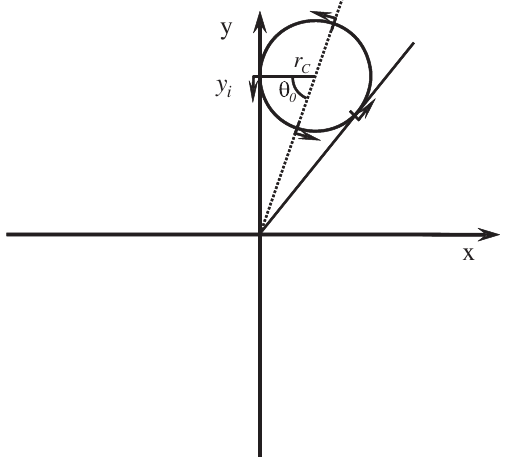
FIG. 20. Schematic of the transverse particle motion in a solenoid field after excitation by a radial kick towards the origin. The initial particle coordinates are y i , x i ¼ 0 , and r C denotes the cyclotron radius. The initial focusing kick is transferred into a pure angular motion with respect to the coordinate center at an ¼ arctan 4 cB 0 angle θ 0 ¼ arctan y i and at θ 0 þ π , while it leads to r C E sin ϕ a pure radial motion at an angle 2 θ 0 . rf forces act only in the radial direction; a compensation is hence possible only when the phase of the cyclotron motion and the rf phase